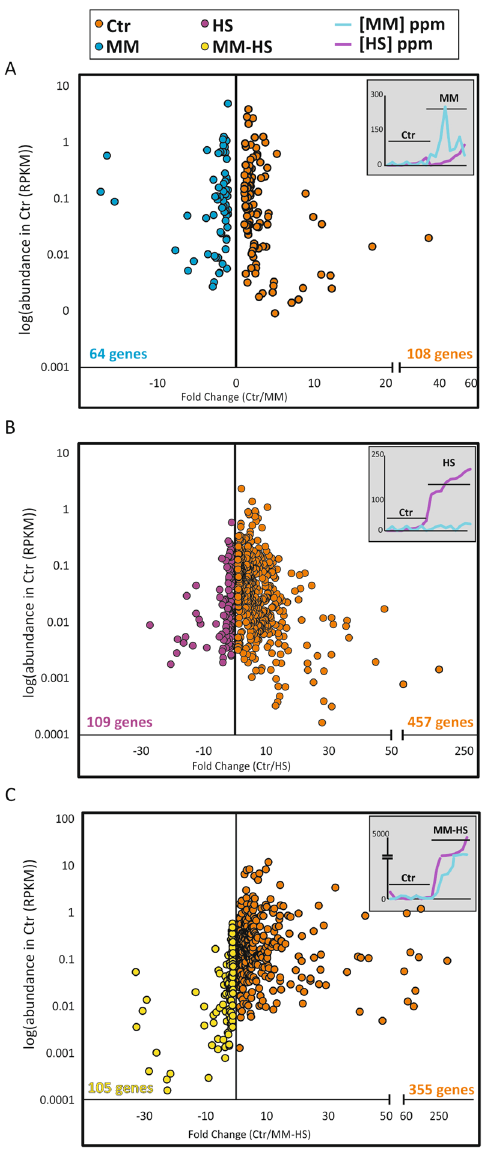
Fig. 5 Microbial differences in gene expression (metatranscrip- tomic) pro fi les. The plots show genes with signi fi cant differences ( p < 0.05; DESeq2 test) in expression between the control group and MM ( A ), HS ( B ) or MM-HS ( C ) groups. The Y-axis indicates the abundance of each gene in the control group whereas the X-axis represents the difference in gene expression, expressed as fold change (Control/Halitosis). The concentrations of VSCs in each sample from the two groups compared are also plotted, for reference. The total number of genes signi fi cantly over-expressed in each group is indicated for each comparison in blue and red. RPKM: Number of mRNA reads normalized by gene length (Kbp) and by sequence coverage pathways 35 . The desulphydration process includes a reverse trans- sulfuration and a cysteine transamination. Regarding the assim- ilatory pathway, we only found cysC (adenylyl-sulfate kinase) over- represented in the HS group compared to the Ctr group out of the 6 genes in this route (Fig. 6A). Interestingly, the homocysteine desulfhydrase ( mccB ), which is one of the three genes responsible for the L-homocysteine conversion into H 2 S, was over-represented